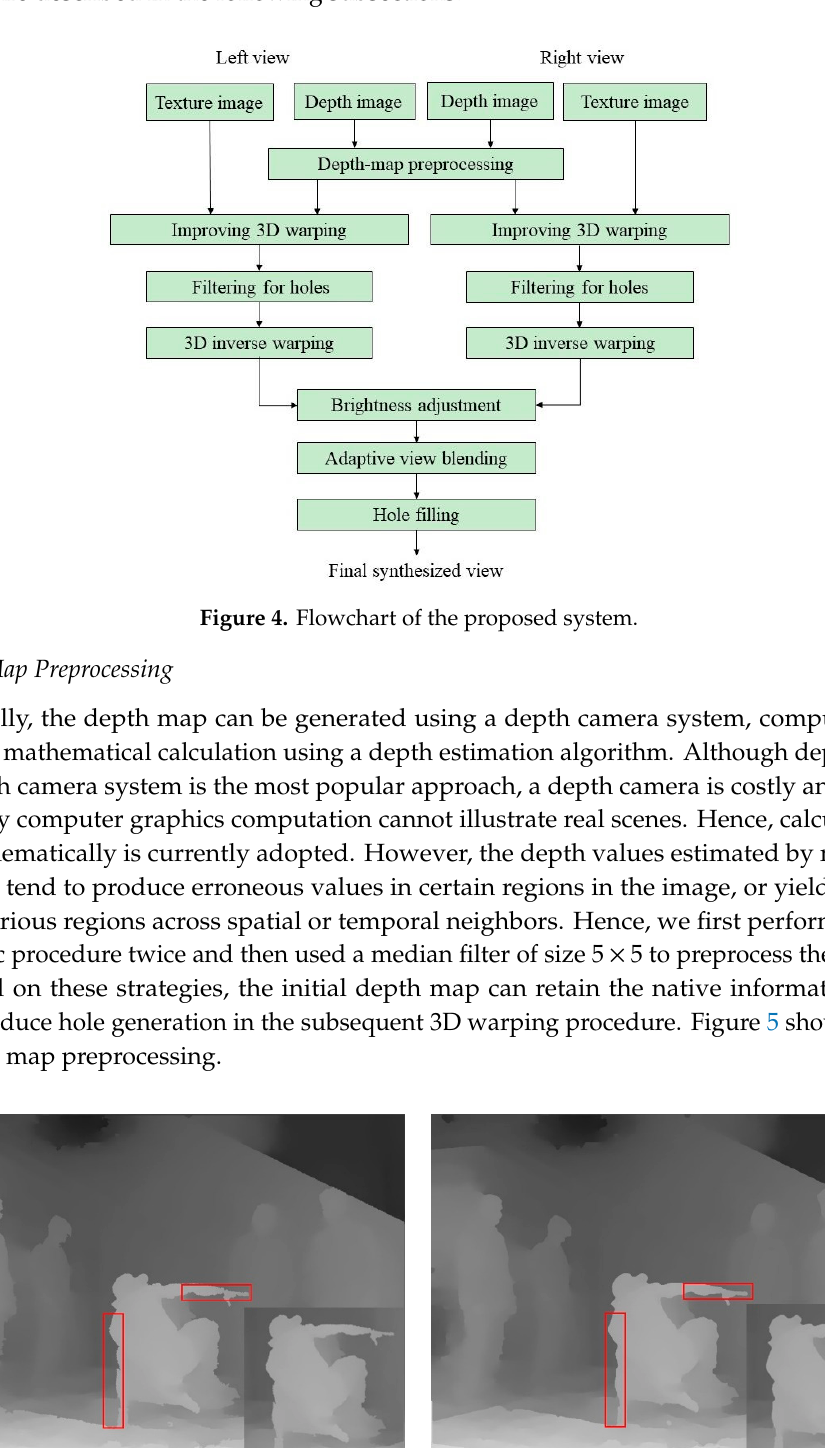
Figure 5. Example of depth map preprocessing for Breakdancers. ( a ) Initial depth map and ( b ) processed result of ( a ).